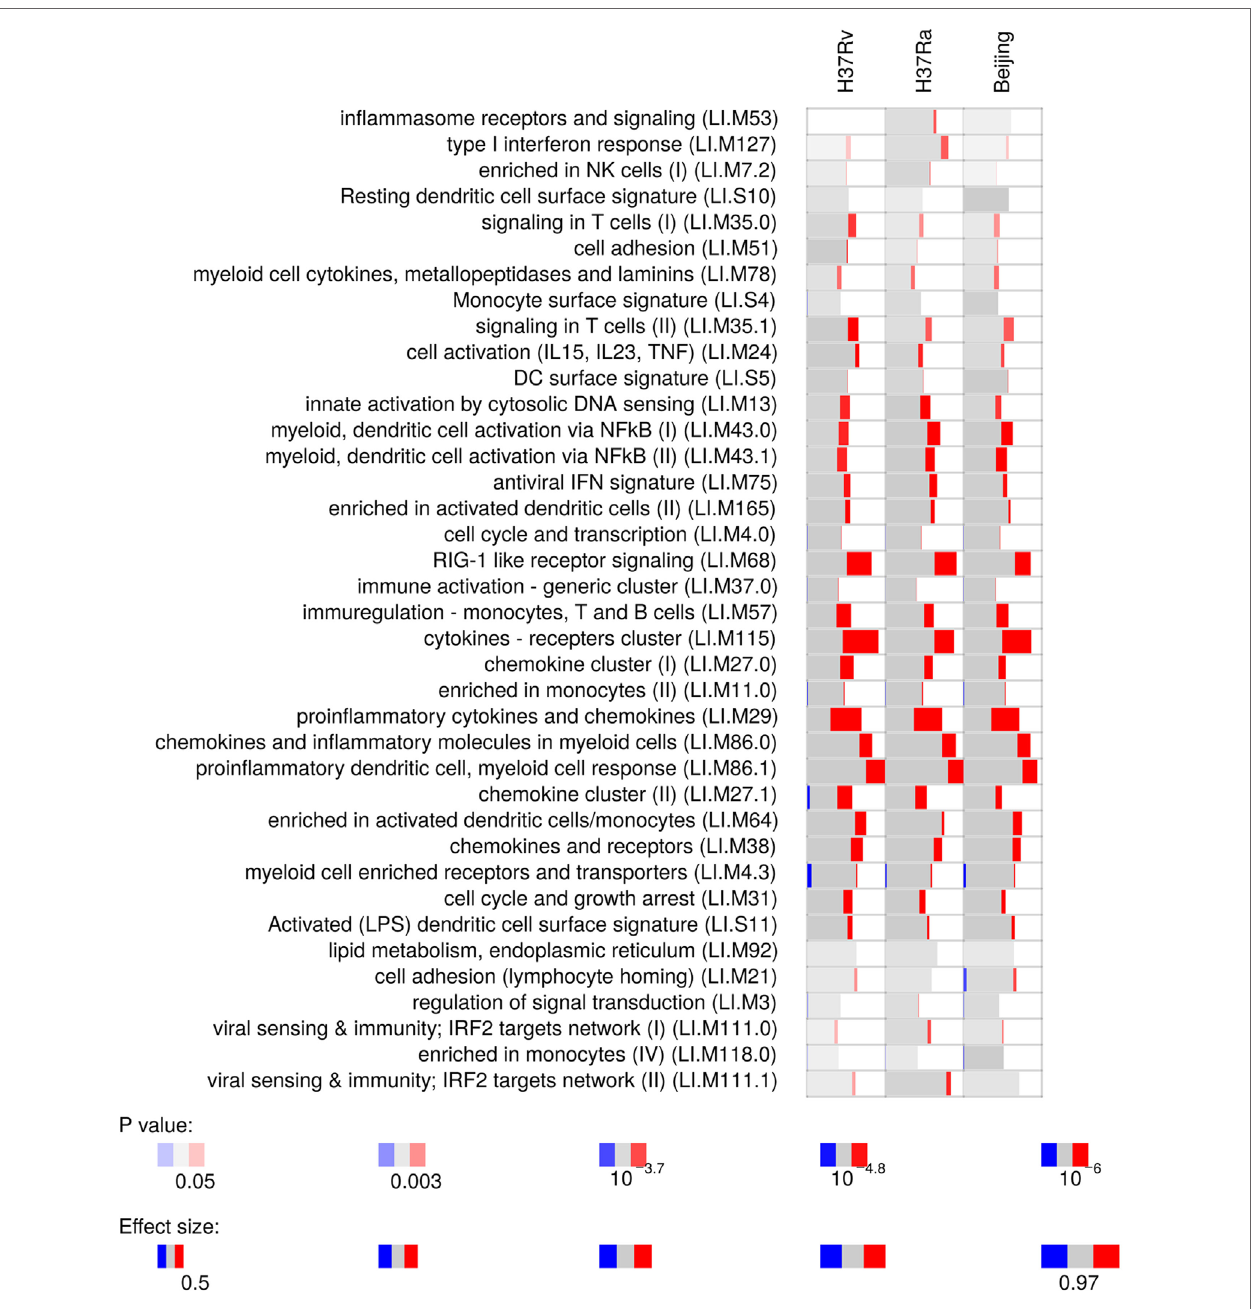
FigUre 2 | Gene module enrichment of lung tissue infected with different strains of Mycobacterium tuberculosis , based on microarray gene expression analyzed with R package tmod. Red indicates the proportion of significantly upregulated genes in each module given on the y